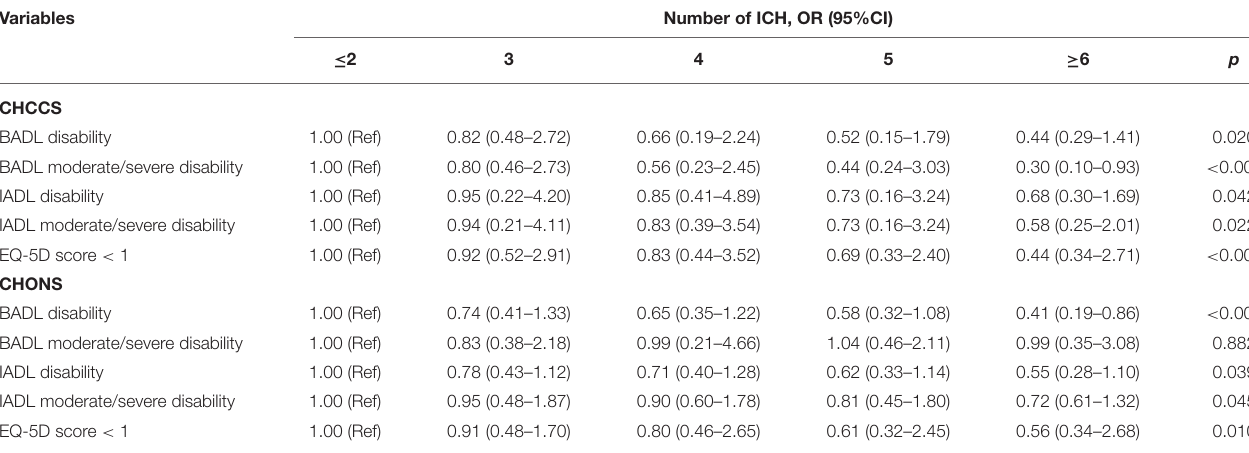
TABLE 4 | Multivariable analysis of ICH with disability and health-related quality of life.